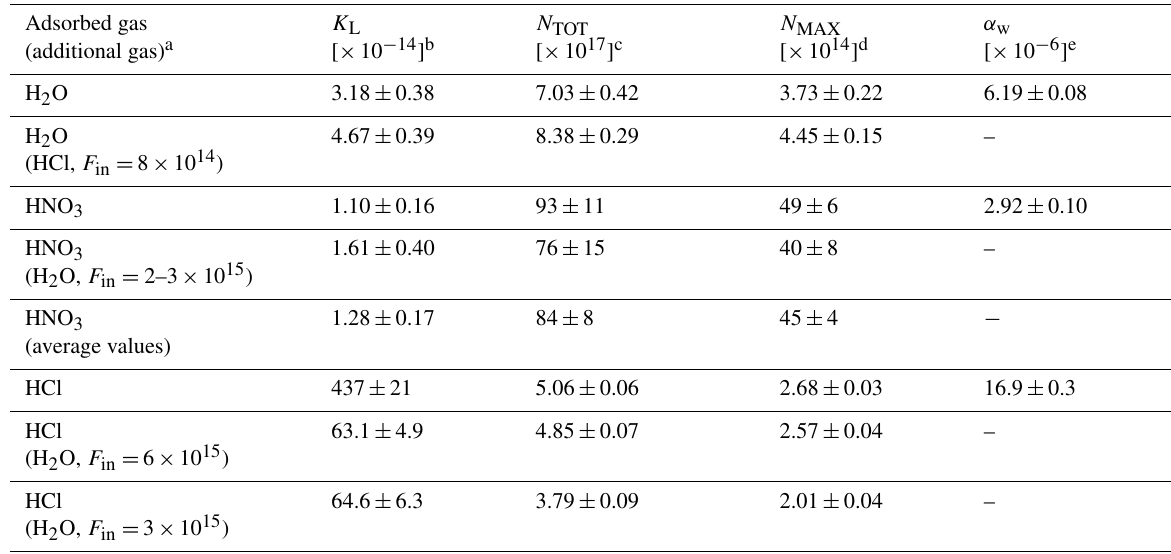
Table 2. Fit parameters of the Langmuir adsorption isotherms for H 2 O, HNO 3 and HCl interaction with the internal stainless steel (SS304) surfaces of the